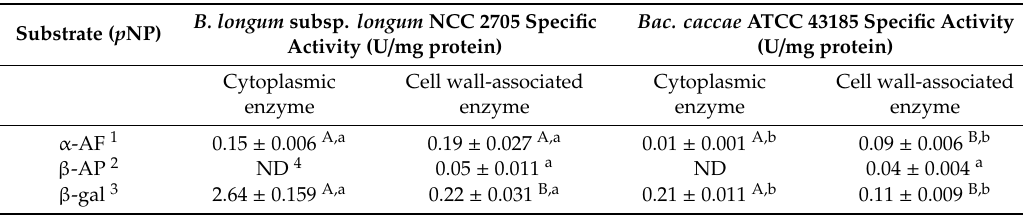
Table 2. Specific activity of the crude enzyme extracts from B. longum subsp. longum NCC 2705 and Bac. caccae ATCC